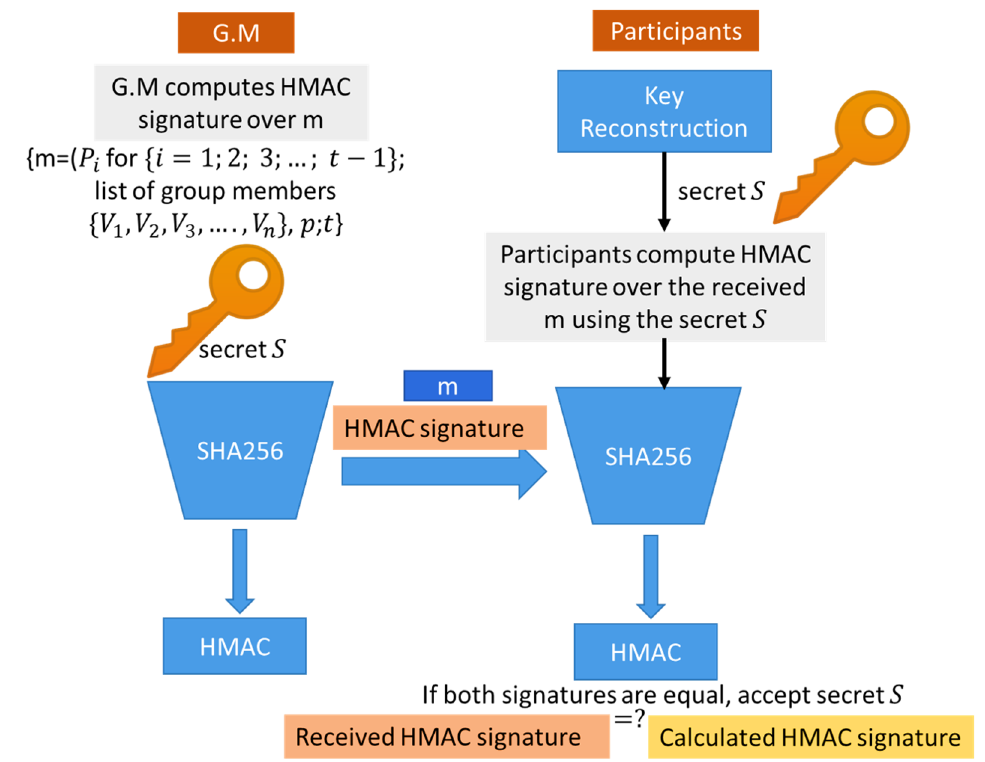
Figure 4. The proposed key authentication process using HMAC.